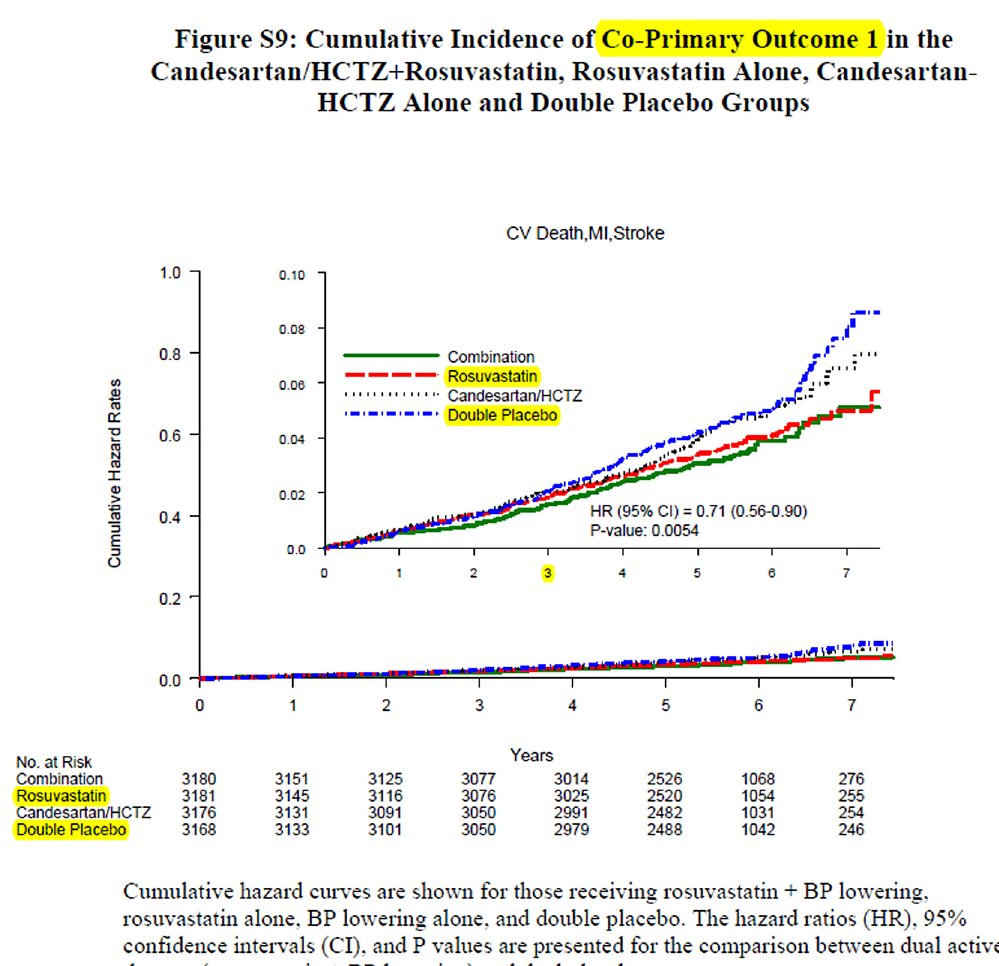
Figure 3. Reproduction of Figure S9 in the Supplementary materials. (Figure reproduced under license from the original